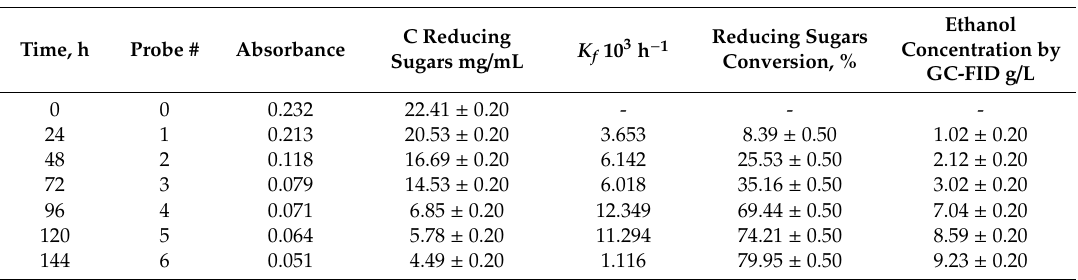
Table 5. Ethanol yield after fermentation of a reducing sugar solution by Consortium